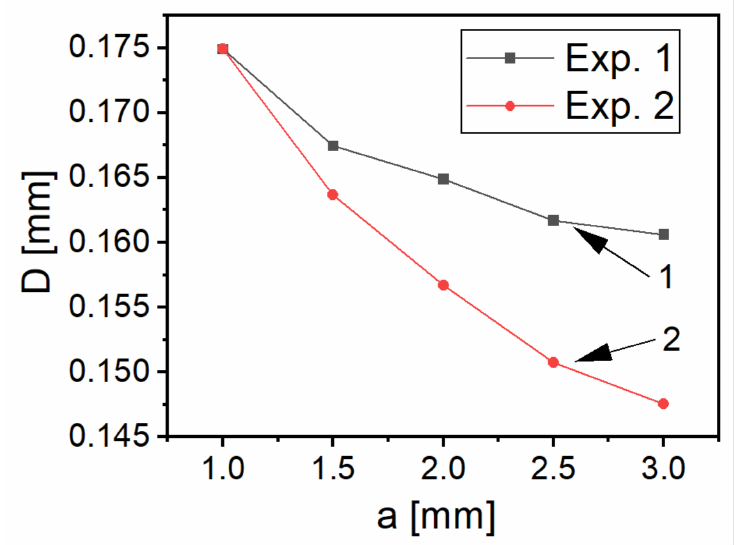
Figure 6. Electron beam diameter as a function of Einzel lens size (plot 1—data for the first experiment, plot 2—data for the second